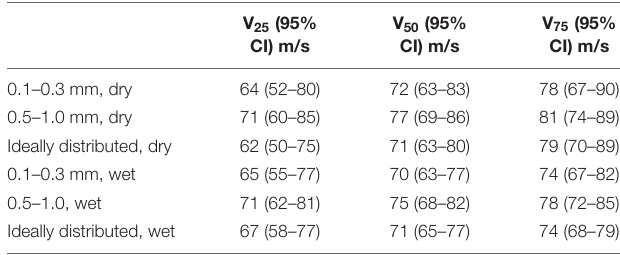
TABLE 2 | The velocities (m/s) at 25, 50, and 75% risk of injury (V 25 , V 50 , and V 75 , respectively) for traumatic amputation across all group.